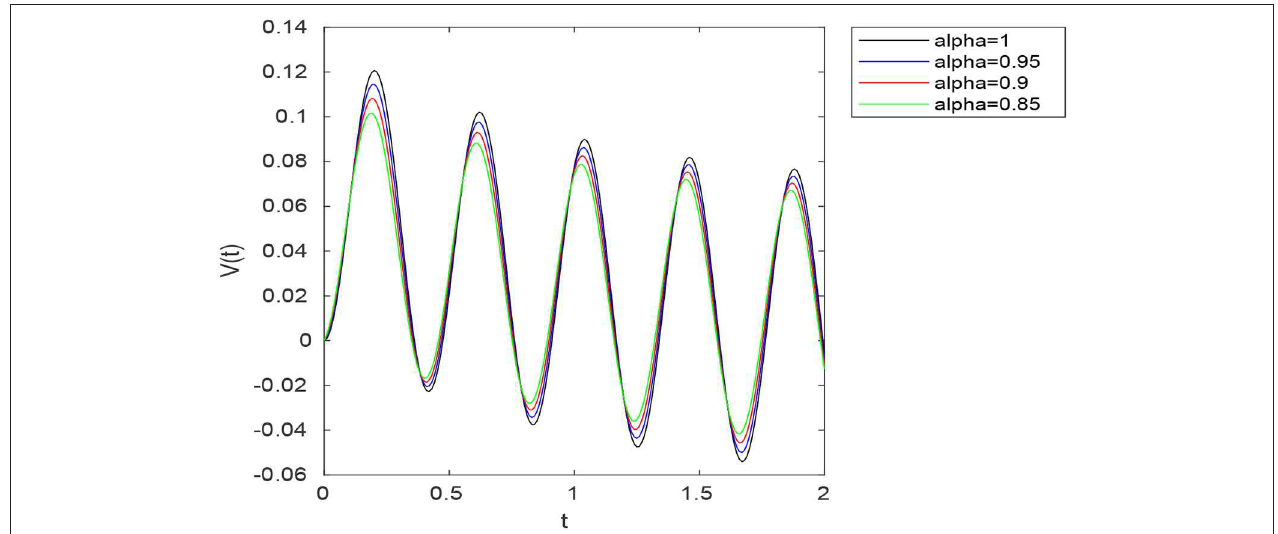
FIGURE 5 | Graph of the voltage in the RC circuit for different values of α with µ ( t )